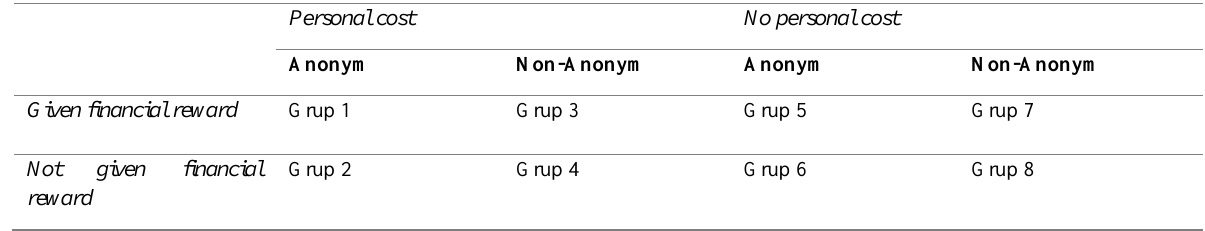
Table 1 : Experiment